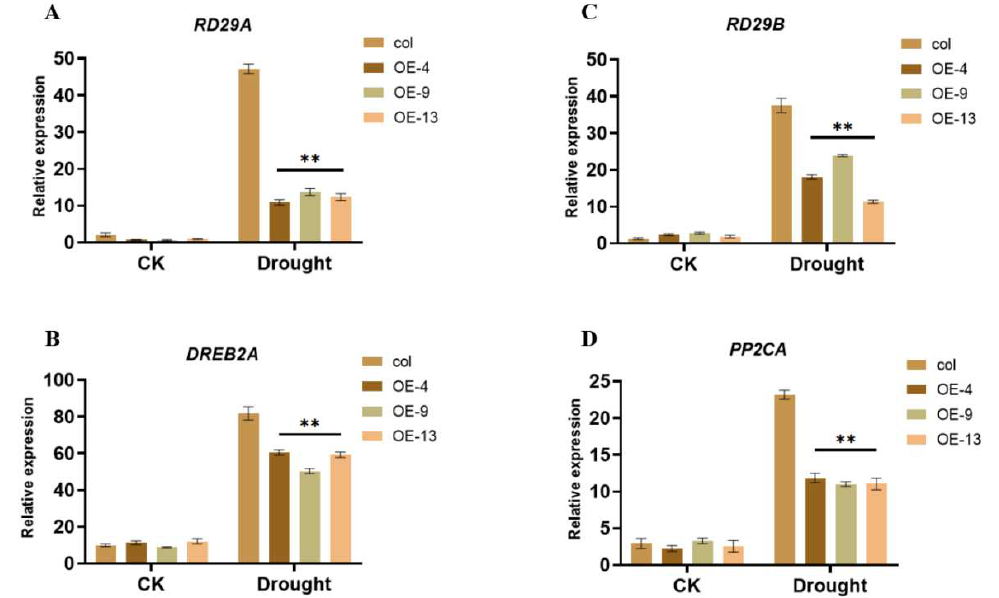
Figure 6. Expression of drought stress response genes in wild-type and ZmGST26 -overexpressing transgenic Arabidopsis leaves. Quantitative real-time PCR analysis was conducted to detect the relative expression levels of ( A ) RD29A , ( B ) RD29B , ( C ) DREB2A and ( D ) PP2CA in three-week-old plants after not watering for 10 days. The AtActin2 gene was used as an internal reference. ** p < 0.01. All bars represent means ± SD, (n ≥ 3).